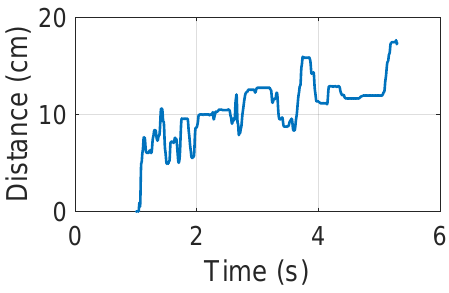
Figure 4. Distance variation during the